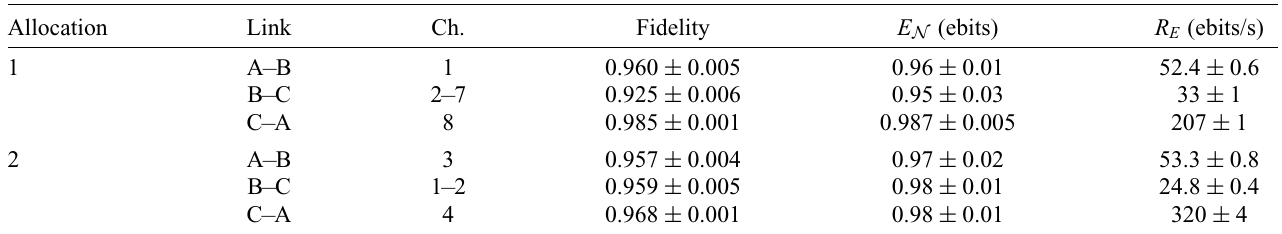
TABLE III. Accidentals-subtracted link data for both bandwidth allocations.